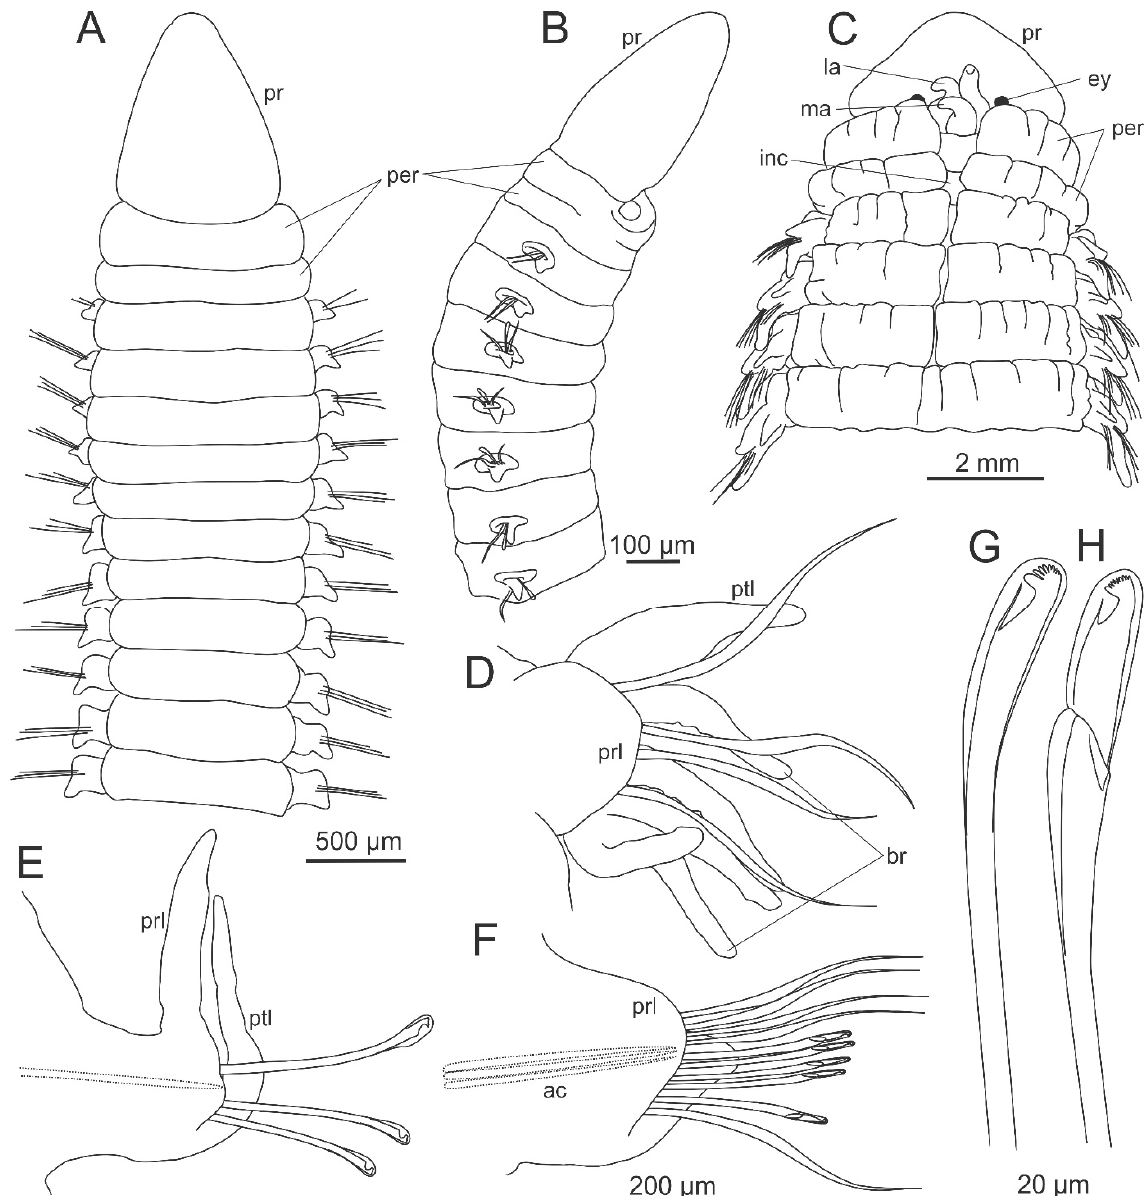
Figure 8. Morphology of Lumbrineridae. ( A ) Lumbrineris mixochaeta Oug, 1998, anterior end, dorsal view; ( B ) Lumbrineriopsis sp., anterior end, lateral view; ( C ) Lysarete sp., anterior end, dorsal view; ( D ) Ninoe vargasi Carrera-Parra, 2001, parapodium; ( E ) Eranno lagunae (Fauchald, 1970), parapodium; ( F ) Lumbrineris sp., parapodium; ( G ) Scoletoma sp., simple hook; ( H ) Lumbrineris sp., compound hook. ac–acicula, br–branchia, ey–eye, ins–dorsal incision, la–lateral antenna, ma–median antenna, per–peristomium, pr–prostomium, prl–prechaetal lobe, ptl–postchaetal lobe.